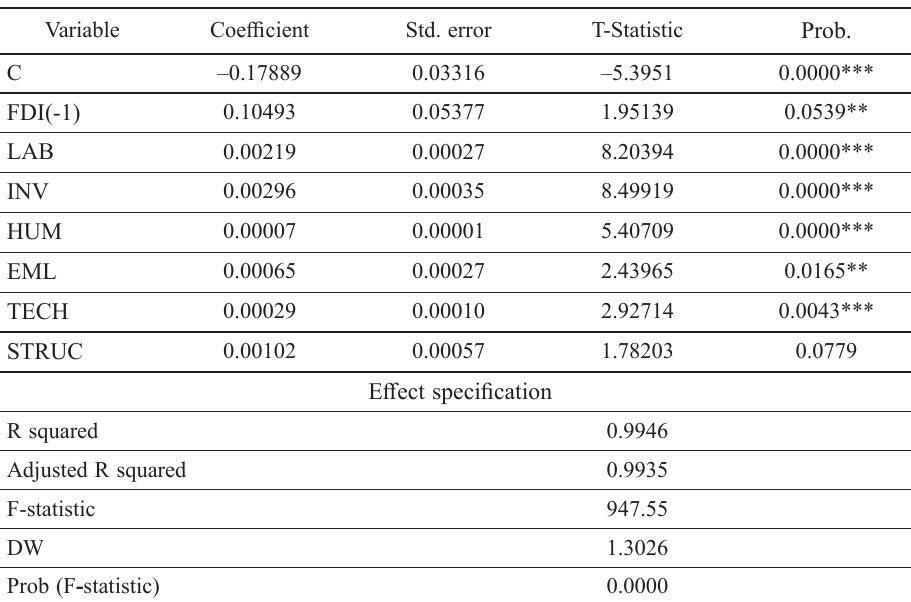
Table 6. Fiscal decentralization effect on economic growth in low level